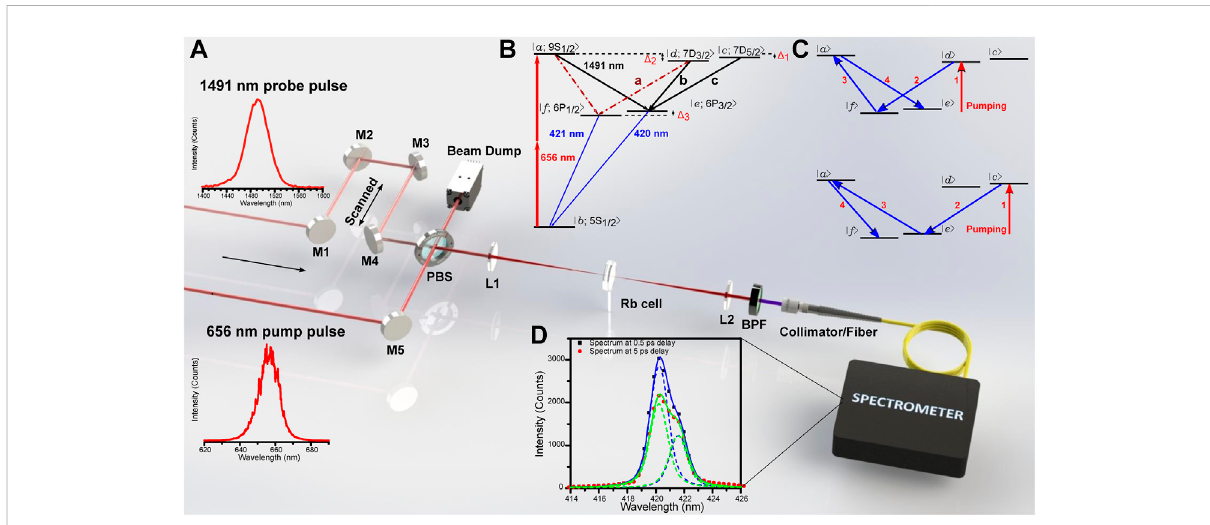
FIGURE 1 (A) Experimental schematics for observing the multichannel quantum beats. The pump (656 nm) and the probe (1491 nm) laser pulses were collinearly combined and focused into the rubidium (Rb) cell. Normalized spectra of the input pulses are shown as they are generated from OPAs. M1 – M5 are mirrors. PBS is a Pellicle beamsplitter. BPFis a band-pass fi lter centered at420 nm with full width at half maximum (FWHM) of 10 nm. (B) Simpli fi edenergy level diagram of 87 Rb. Broadbandpumppulses excite atoms from 5 S to both 9 S and 7 D levels; probepulses couple 9 S and 7 D levels to 6 P levels. (C) Illustrations of fourth-order quantum paths, which result in exchanging transition probabilities of the two 6 P fi ne structure levels and beat pattern ’ s envelope oscillations as discussed in the text. (D) Spectra of the emission (black and red dots) measured at a delay time of 0.5 and 5 ps between pump and probe pulses; two distinguishablelines (dashed lines) at420 and 421 nm are fi ttedto each spectrum. The solid lines are the sum of the fi tted Voigt pro fi